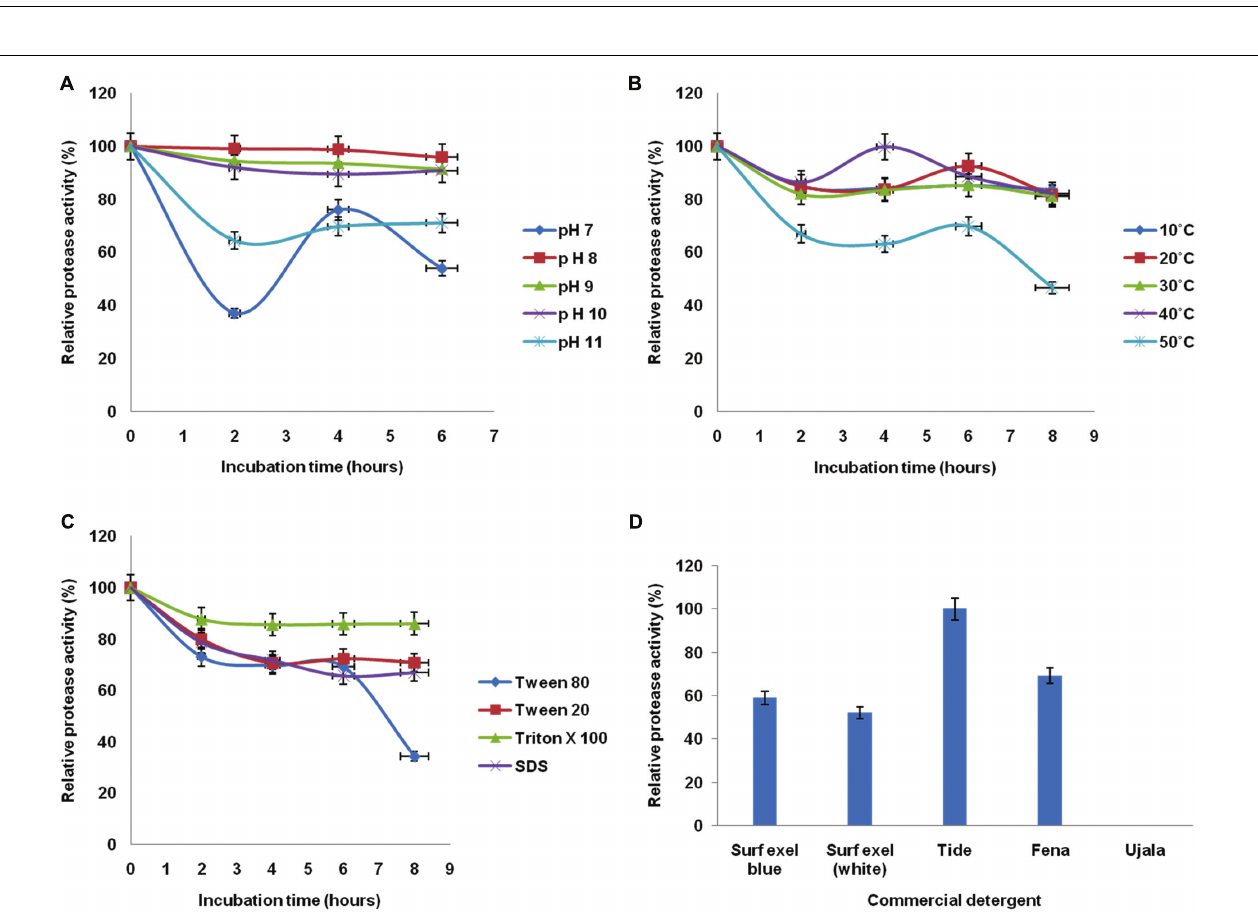
FIGURE 4 | Evaluation of stability of alkaline protease in presence of physico-chemical factors from B. pumilus MP 27 at different intervals (A) pH, (B) Temperature, (C) Surfactant, (D) Commercial detergent.